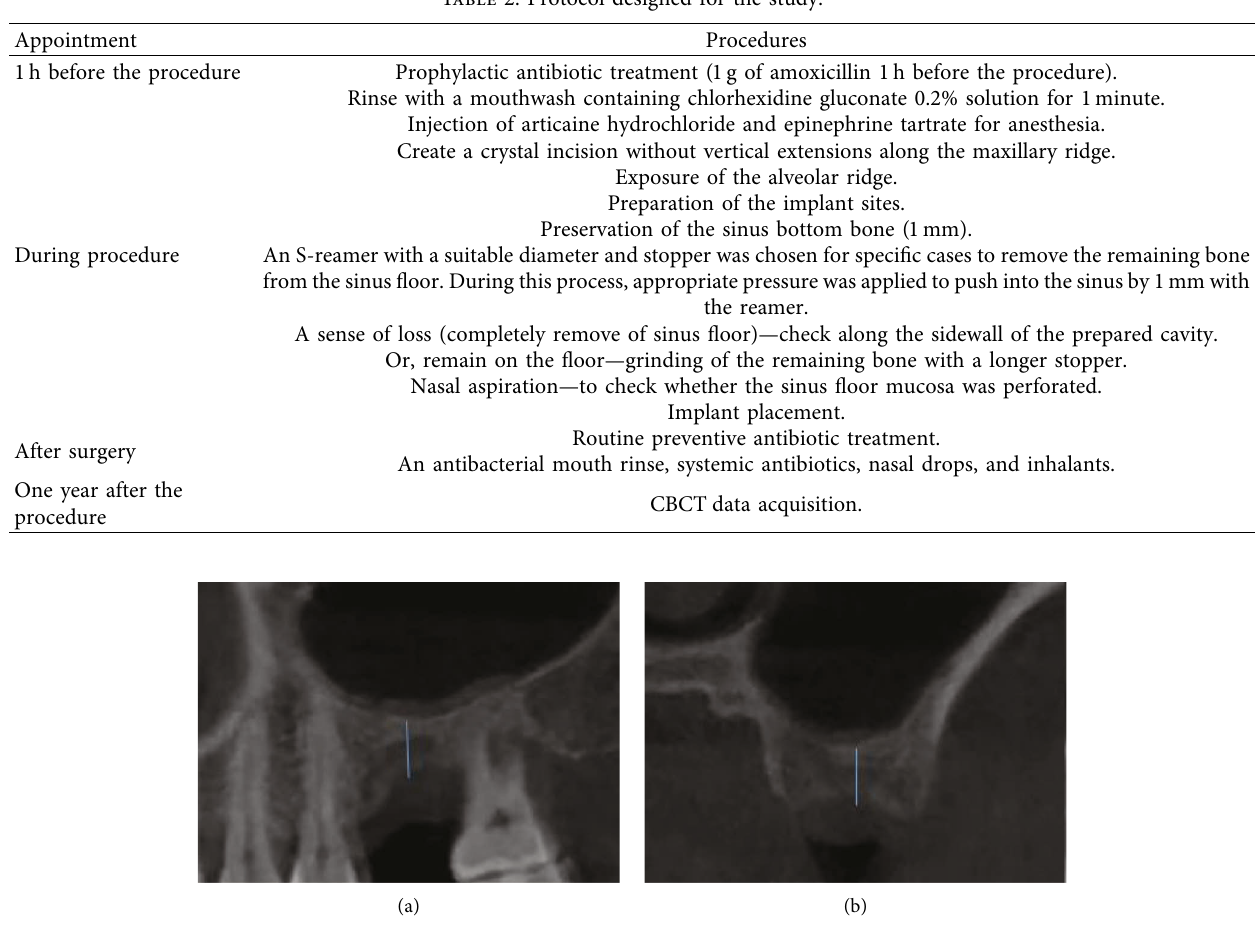
Figure 3: Residual bone height (RBH) based on the (a) sagittal plane and (b) coronal